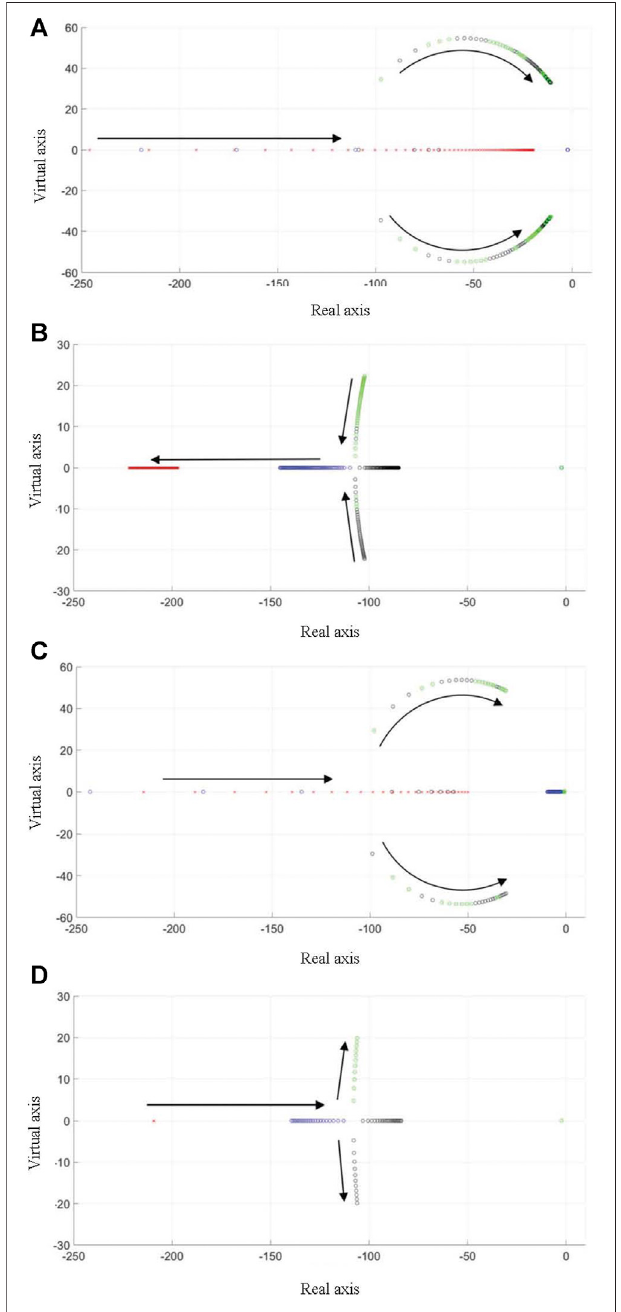
FIGURE 5 | Root locus diagram. (A) with different inertia J (B) with different damp coef fi cient D p . (C) with different droop parameter k p . (D) with different droop parameter k q